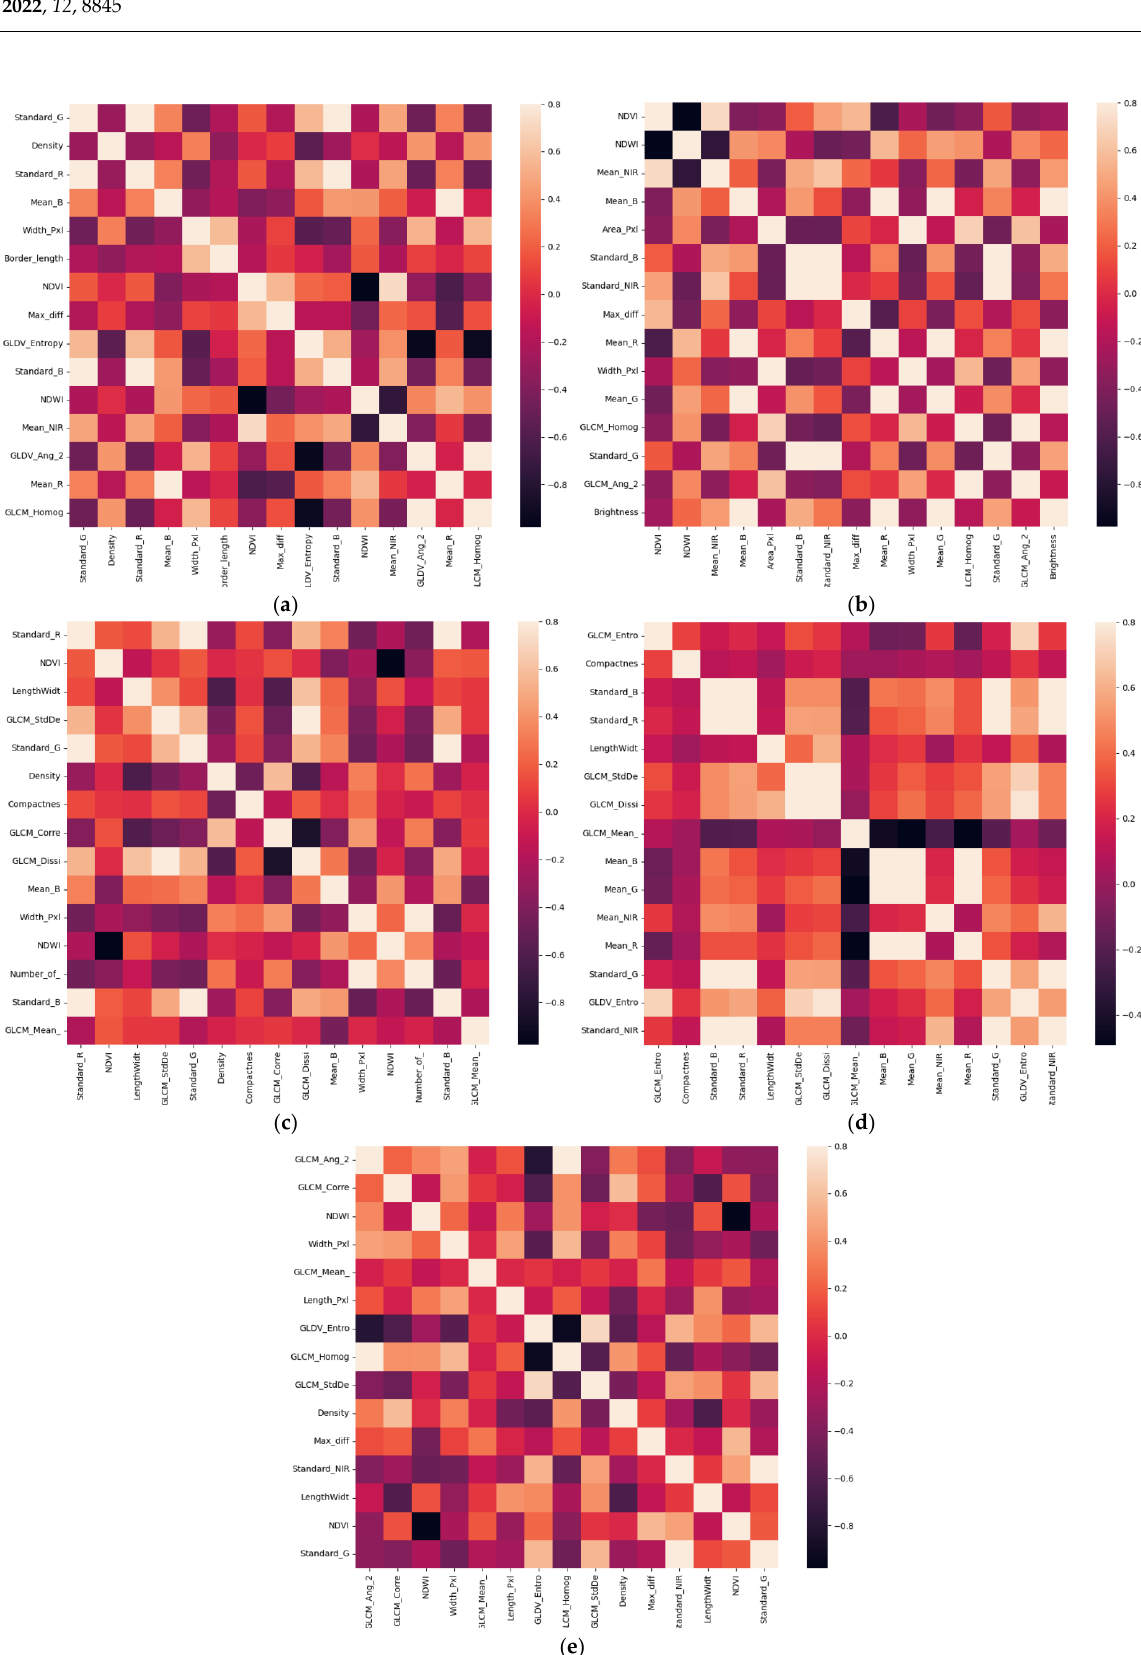
Figure 4. The correlation matrix of the top 15 features of the five feature selection methods: ( a ) Fm;